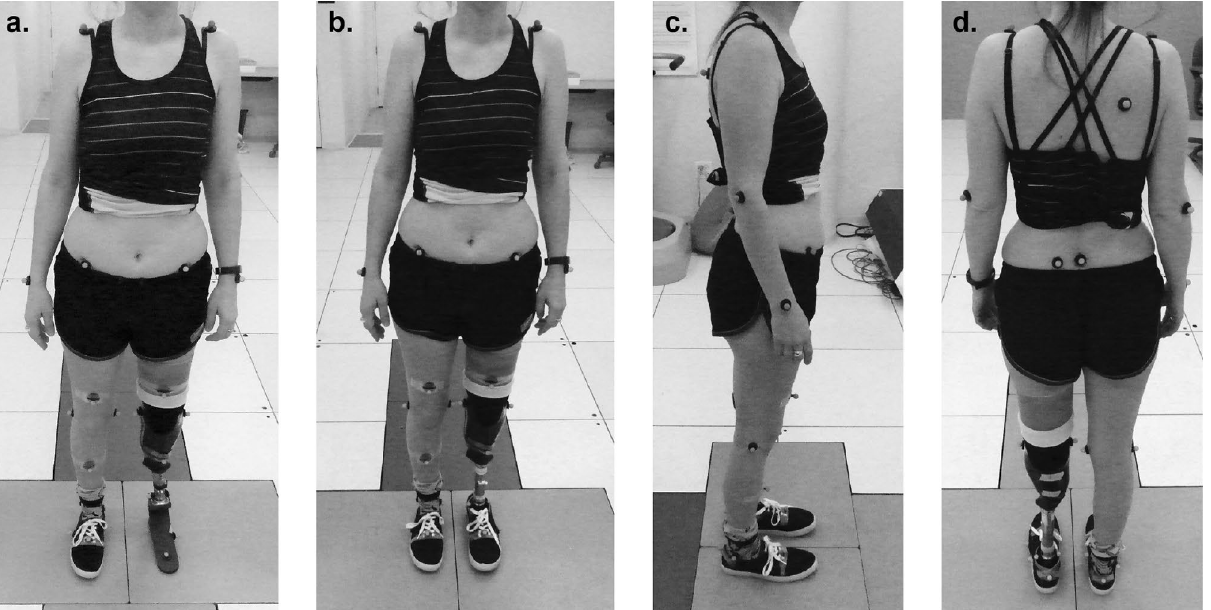
Figure 2. Experimental photographs describing the motion capture marker set placed on a representative participant. Frontal view are shown for the LLTE prosthetic foot condition ( a ) and the Horizon LT control foot condition ( b ). Lateral and back views are shown for the Horizon LT control foot condition ( c , d